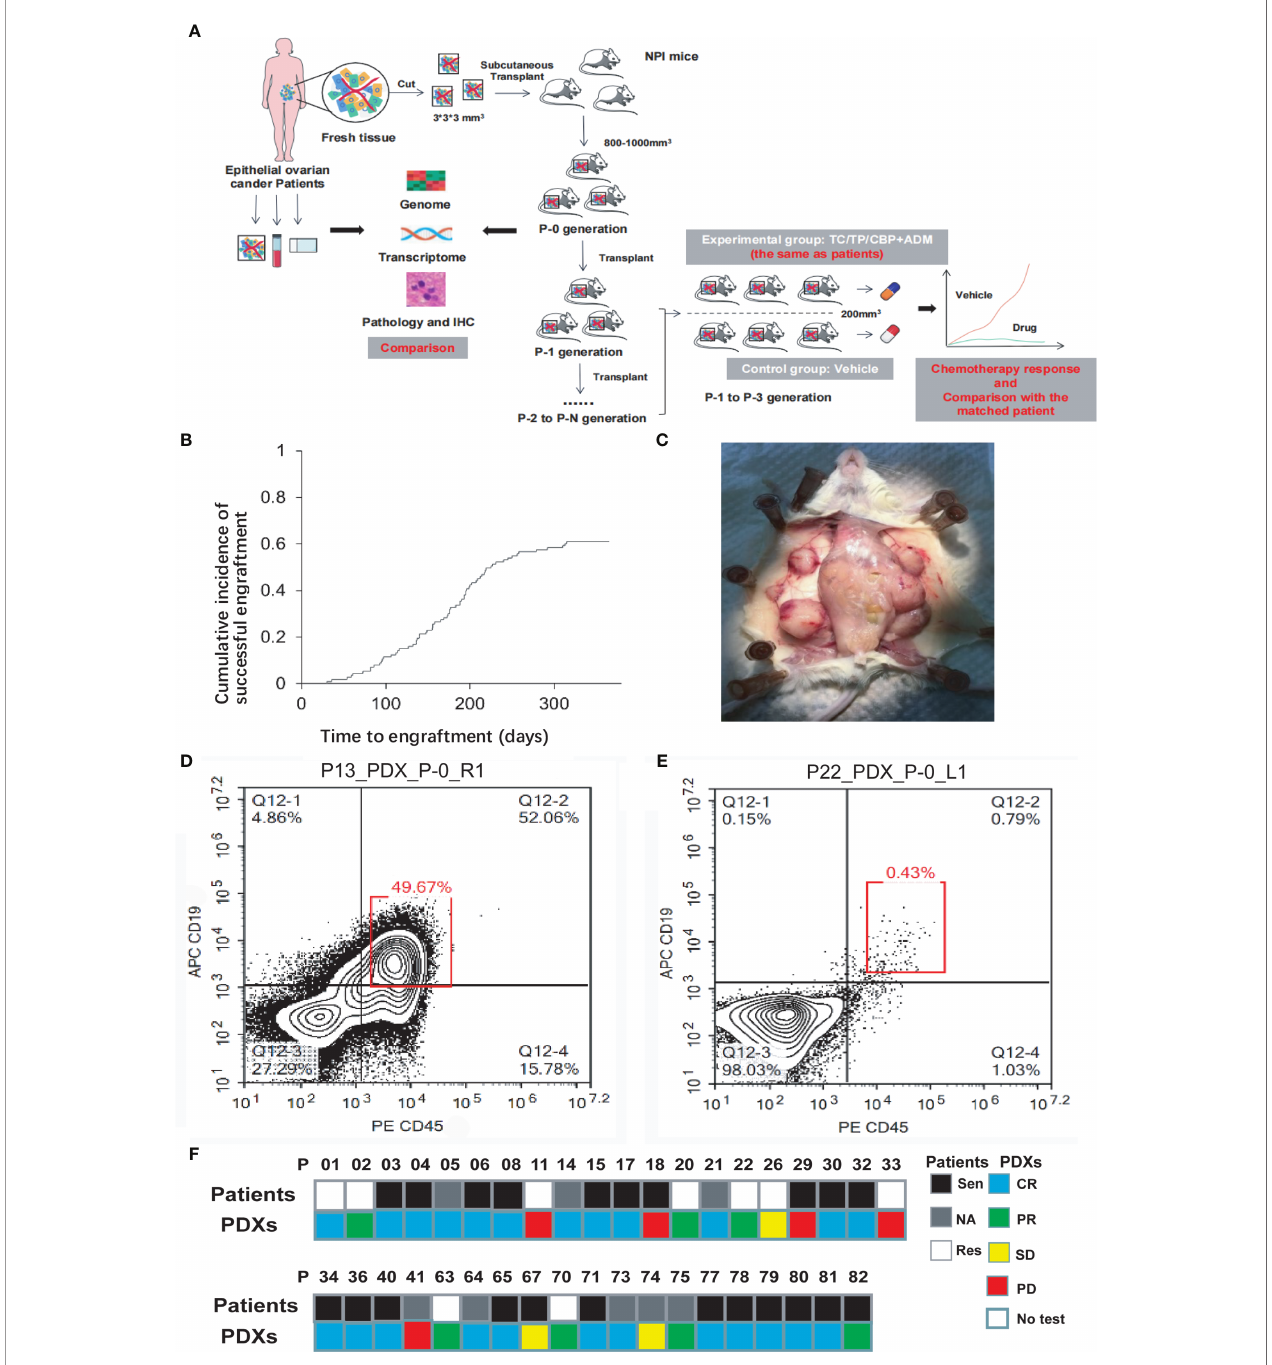
FIGURE 1 | (A) The protocol of whole experiment. (B) The successful engraftment rate increased over time and was 61.1% 1 year after subcutaneous implantation into mice. (C) This panel shows a representative image of the gross appearance of EOC-PDX tumors. Four sites of engrafted tumors (white triangle) have grown to be harvest. (D, E) Whether human lymphoma existed in PDX models was quickly checked according to the proportion of CD19+CD45+ cells (red box) via fl ow cytometry. A proportion of <1% suggested a “ clean ” PDX model without the development of lymphoma. (F) Comparison of chemotherapy ef fi cacy between patients and paired PDX models in 39 patients. The chemotherapy regimens were identical. NPI, NOD-Prkdcem1Idmo-Il2rgem2Idmo; TC, paclitaxel/carboplatin; TP, paclitaxel/cisplatin; CBP, carboplatin; ADM, doxorubicin; Sen, Sensitivity; Res, resistance; CR, complete remission; PR, partial remission; SD, stable disease; PD, progressive